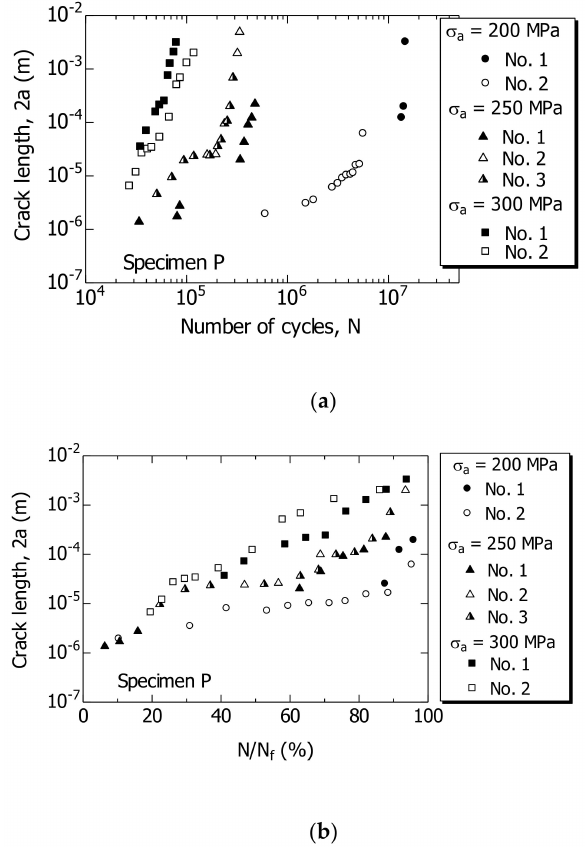
Figure 7. Changes in crack length 2a during fatigue process of specimen P. ( a ) 2a–N; ( b ) 2a–N/N f